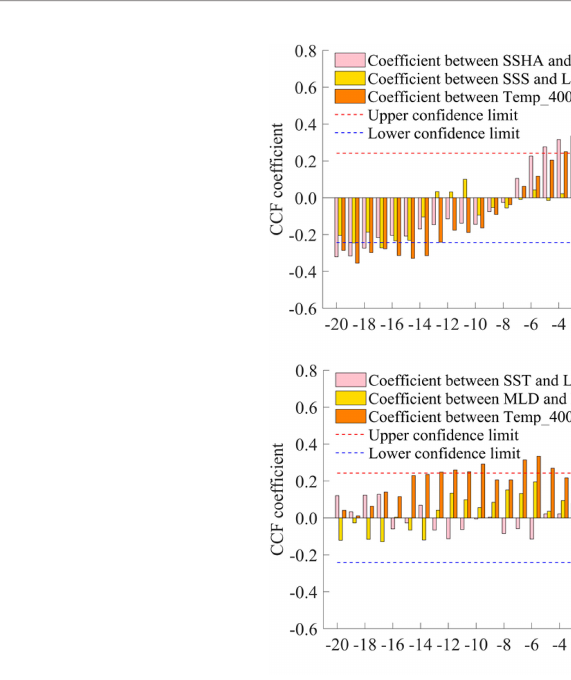
FIGURE 9 | Cross-correlation coef fi cients of key environmental factors of Dosidicus gigas (top panel) and Trachurus murphyi (bottom panel) and latitudinal gravity center of habitat suitability